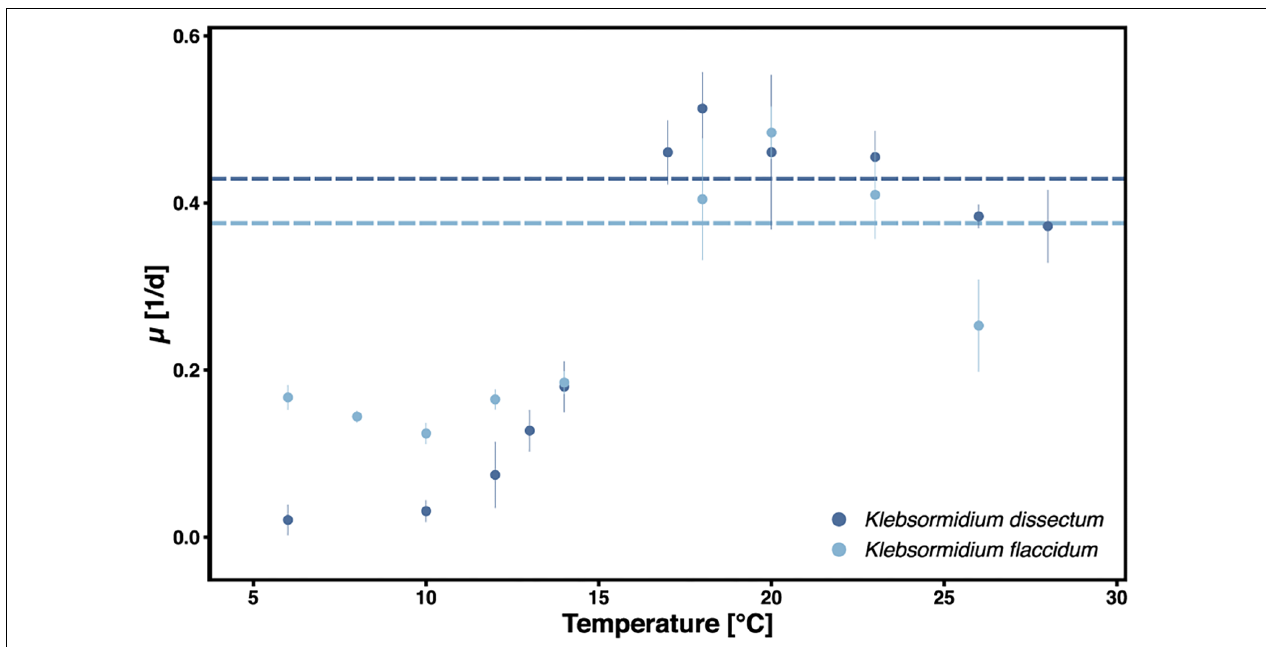
FIGURE 1 | Growth of K. dissectum and K. flaccidum at different temperatures. The growth rate µ was determined for exponential cultures. Bars indicate standard deviation. Horizontal lines indicate the mean maximal growth rate between 12 and 28 ◦